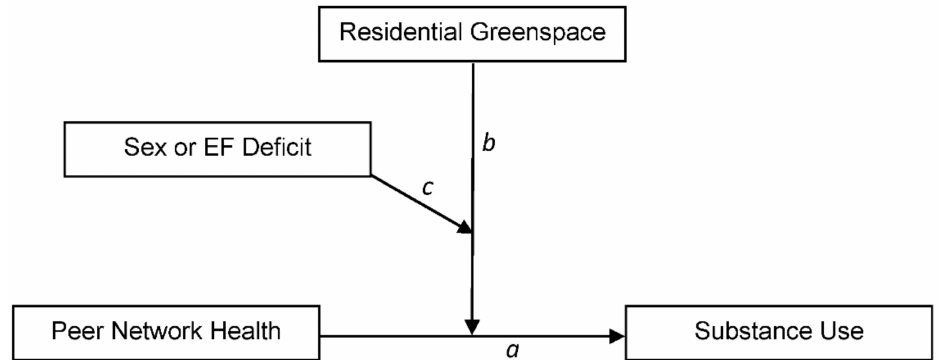
Figure 2. Conceptual diagram of moderated moderation models testing Hypotheses 2 and 3, where the direct effect of peer network health on substance use (path a ) is moderated by resi- dential greenspace exposure (GVI; path b ), which in turn is moderated by sex or EF deficit (path c ; Hypotheses 2 and 3,